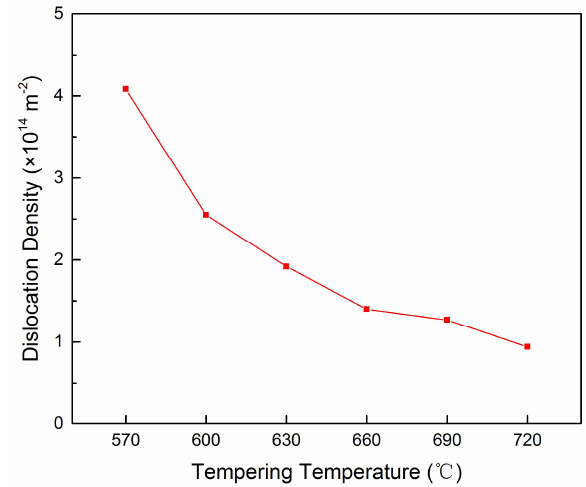
Figure 8. Dislocation density of 42CrMo4-V steel tempered at 570–720 °C.